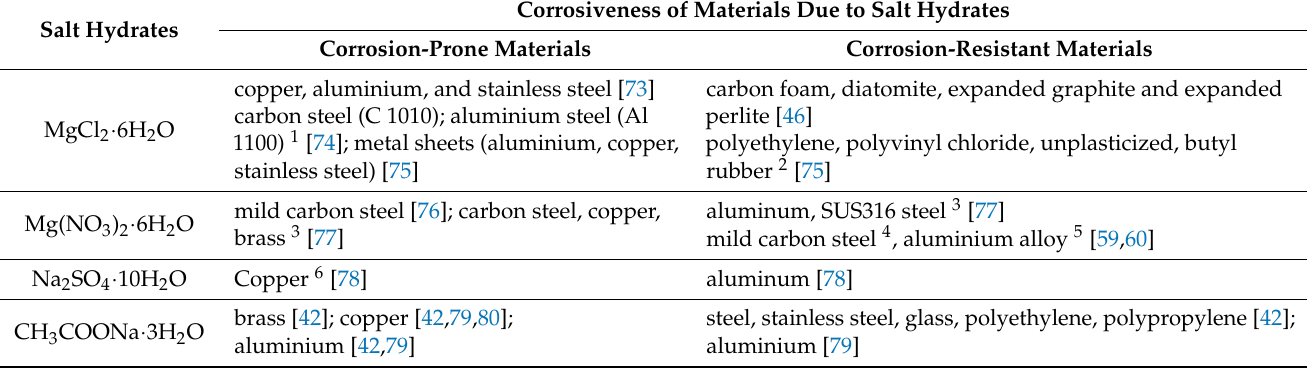
Table 4. The ability of salt hydrates to cause